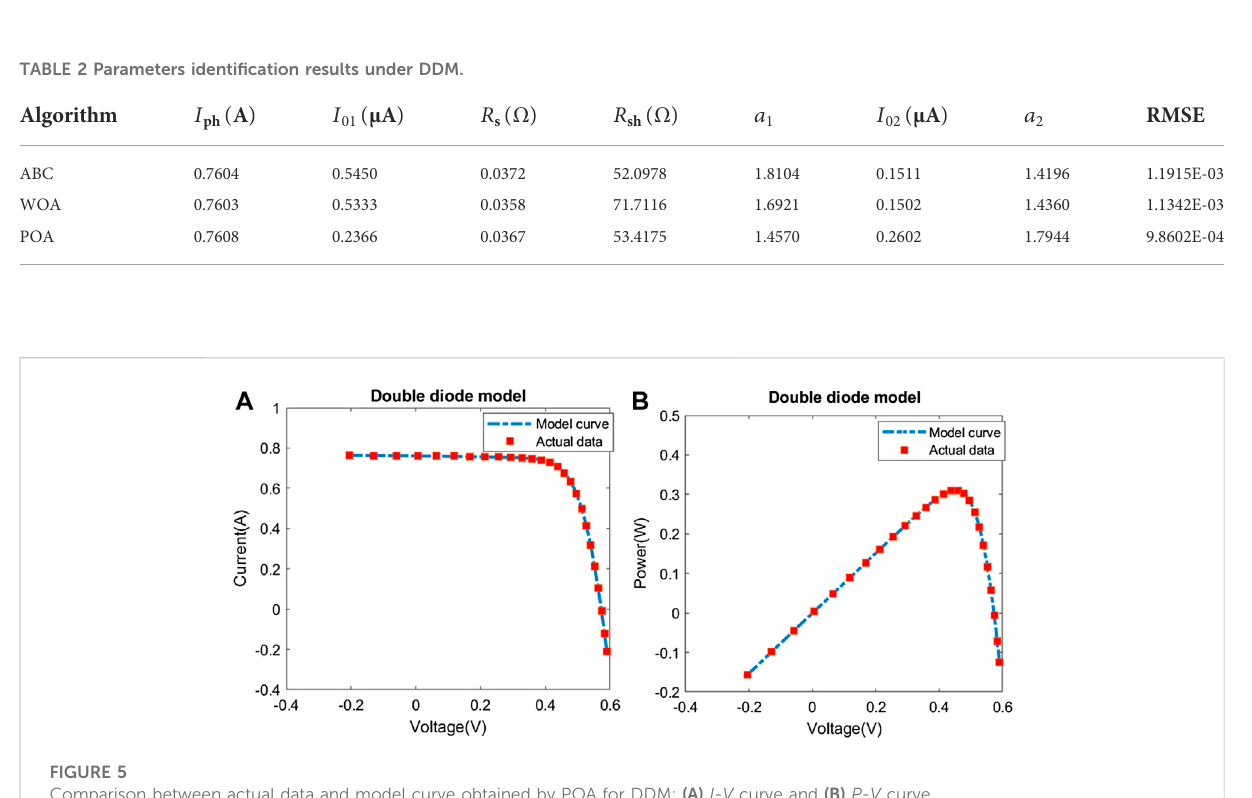
Frontiers in Energy